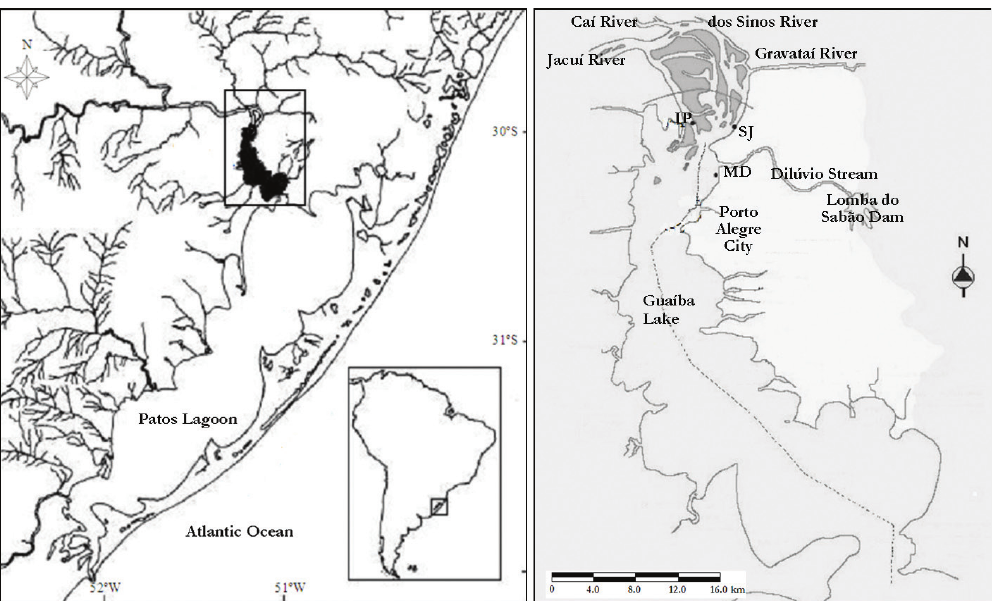
Figure 1. Study area and the IP, SJ and MD sampling sites in Guaiba Lake, Rio Grande do Sul State,